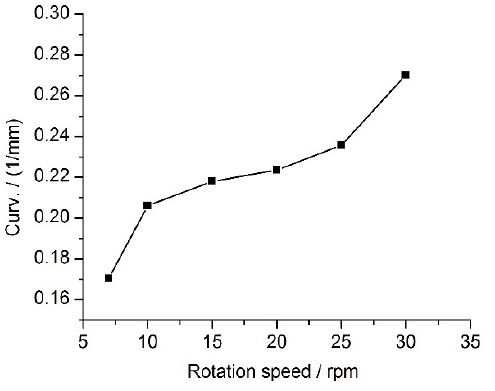
Figure 6. Correlation between striation curvature and seed‐rod rotation speed (for sample #6).